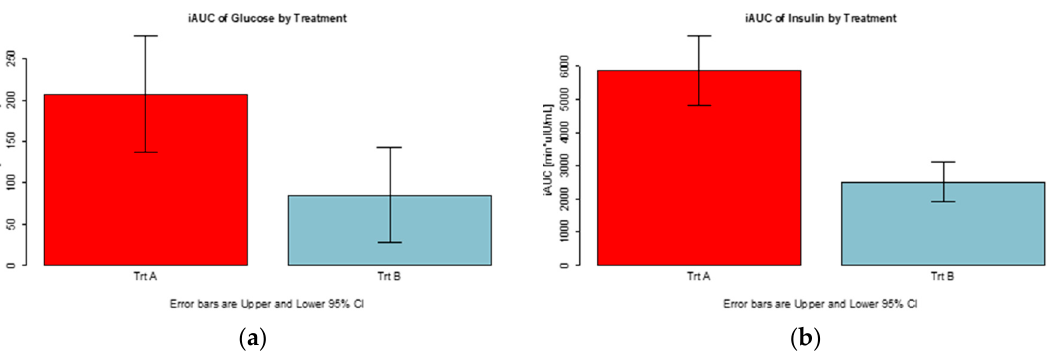
Figure 3. Integrated areas under curve (iAUC) of the blood glucose and insulin concentrations elicited over a period of 180 minutes by 100 g white bread consumed with either 250 mL plain drinking water (treatment A) or 100 g white bread consumed with 250 mL drinking water containing 10 g dissolved alpha-cyclodextrin (treatment B). Values are the means for 12 subjects with their SEMs represented by vertical bars. ( a ) integretated area under curve of blood glucose by treatment, ( b ) integrated area under curve of blood insulin by treatment.